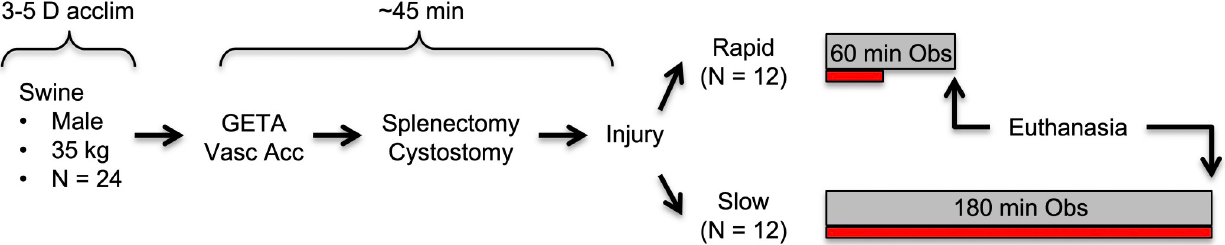
Fig 1. Experiment flow chart. Swine were acclimatized (acclim), then on the procedure day underwent general endotracheal anesthesia (GETA), followed by access of the carotid and jugular vessels (Vasc Acc), and then other preparatory procedures. After injury, subjects underwent IV crystalloid resuscitation (maximum volume allowed = 100 mL/kg) for the indicated observation period (Obs). Red bar underneath each observation period indicates relative time required for crystalloid infusion.